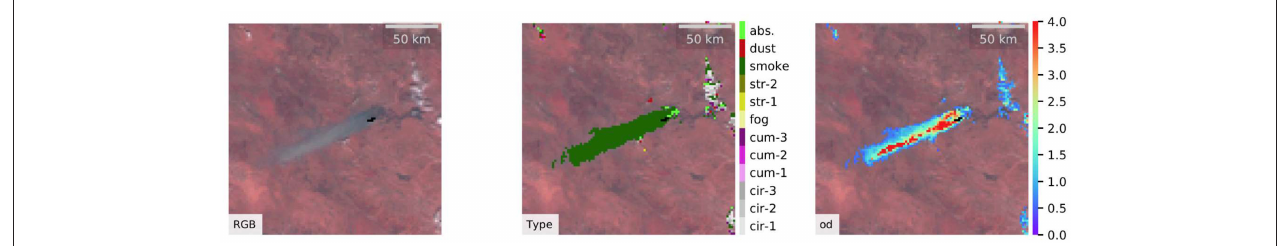
FIGURE 11 | Detected smoke over the northern Australian continent at (134 ◦ E ,20 ◦ S ) at 02:00 UTC on 10th Nov 2015.